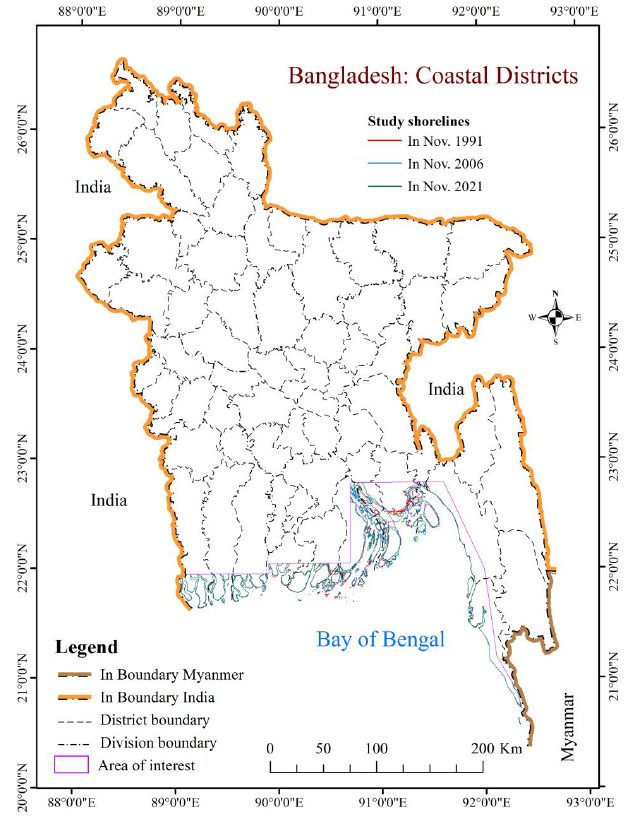
Figure 6. Study shoreline combinations of Bangladesh from 1991 to 2021 (15-year interval).